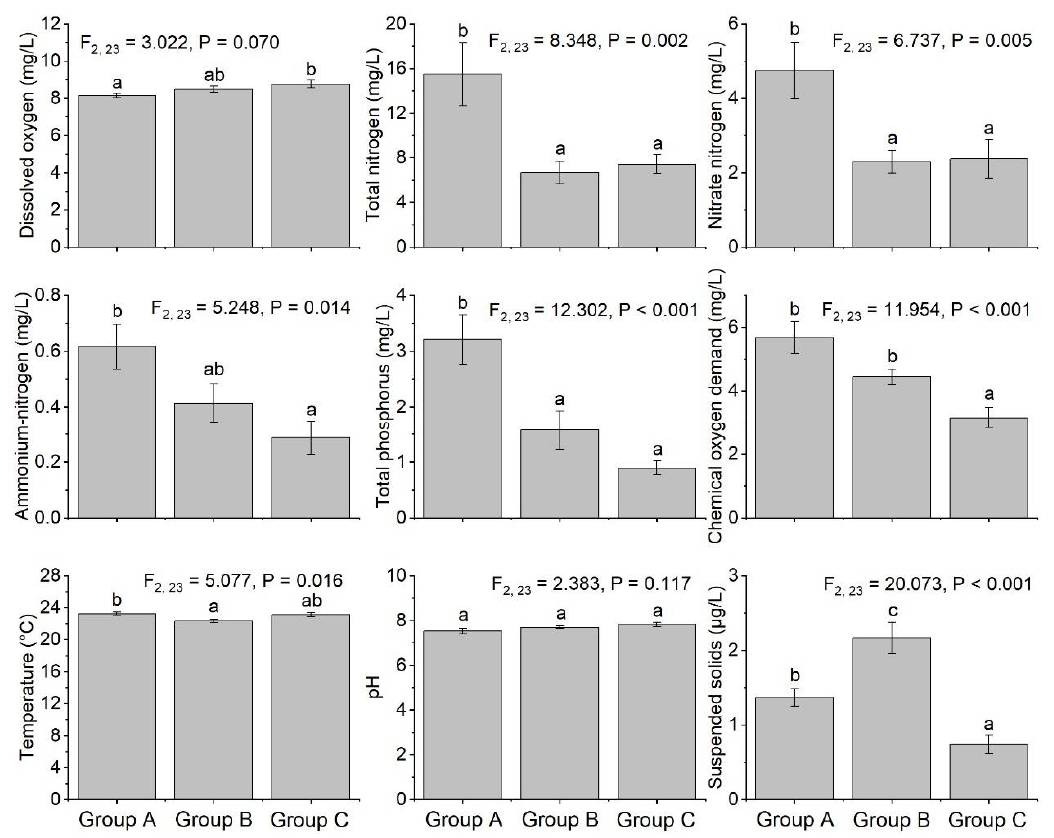
Figure 3. The differences in water quality variables among the three groups. Data are expressed as the mean ± SE and letters indicate significant differences based on post hoc tests. Table 1. Summary of eigenvalues between the axis and the variable produced by PCA using standardized values of nine environmental variables.